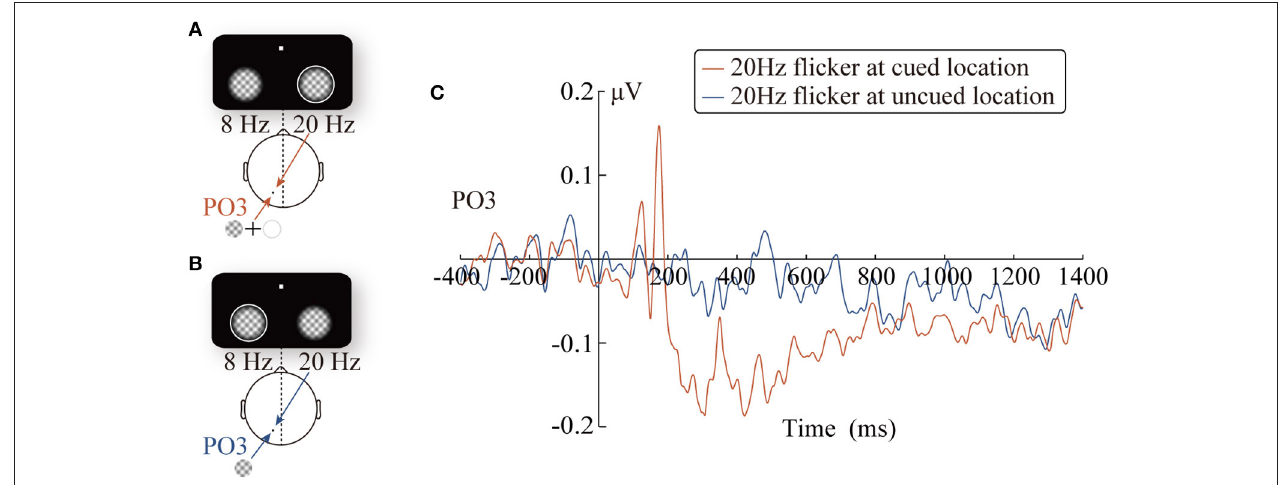
FIGURE 5 | The diagrams of the two experimental conditions: the 20 Hz flicker was cued (A) and uncued (B) . Grand-average SSVEP waveforms at the PO3 electrode elicited by the 20 Hz flicker stimulus (C) .